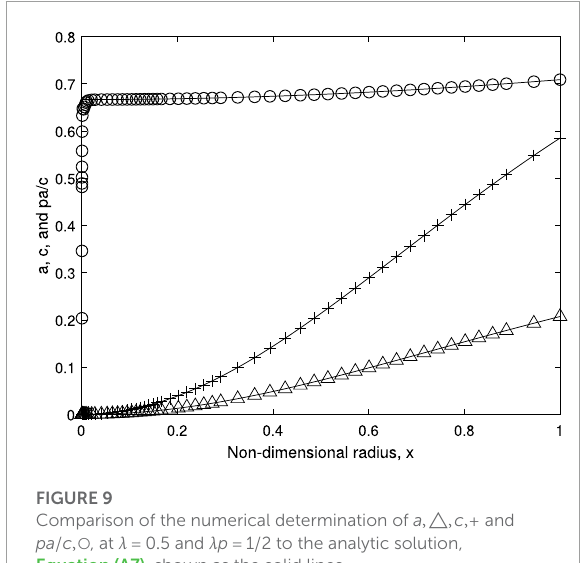
FIGURE 9 Comparison of the numerical determination of a , △ , c ,+ and pa / c ,○ , at λ = 0 . 5 and λ p = 1 / 2 to the analytic solution, Equation (A7) , shown as the solid